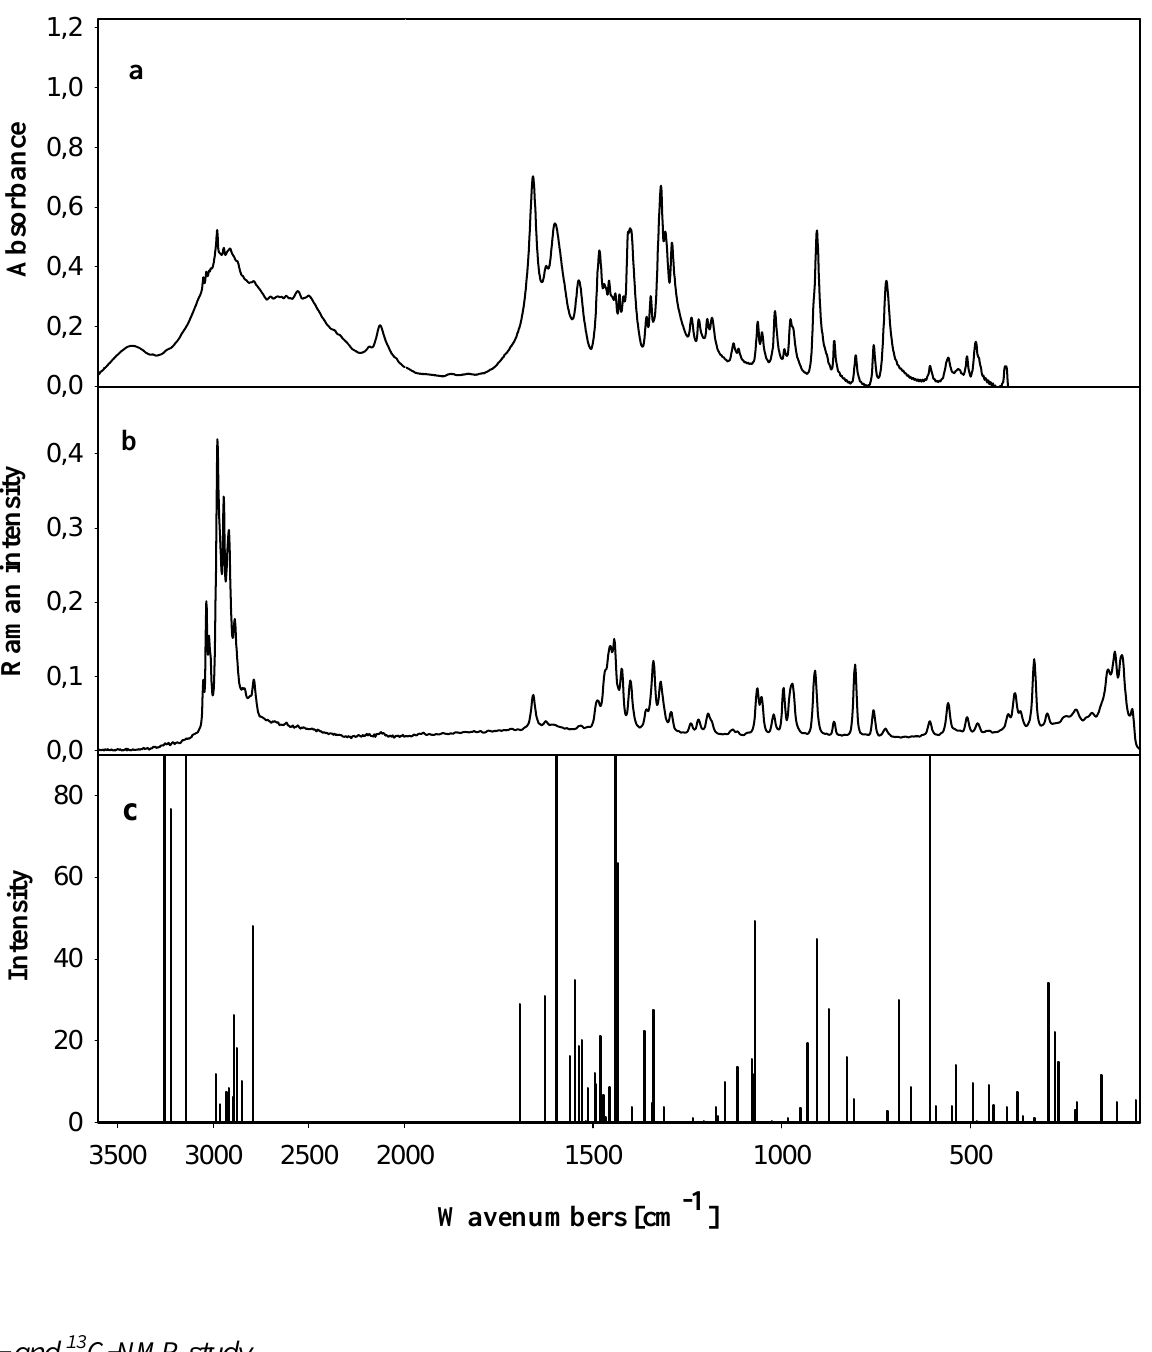
Figure 3 . Spectra of 1,1-dimethyl-1-carboxymethyl-3-aminopropyl ammonium hydro- chloride ( 2 ): (a) FTIR (suspension in Nujol and Fluorolube), (b) Raman and (c) calculated